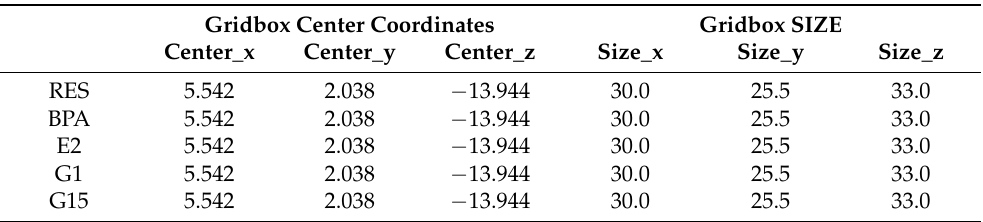
Table 1. Molecular docking parameters between GPER and five estrogens and estrogen analogs. Gridbox Center Coordinates